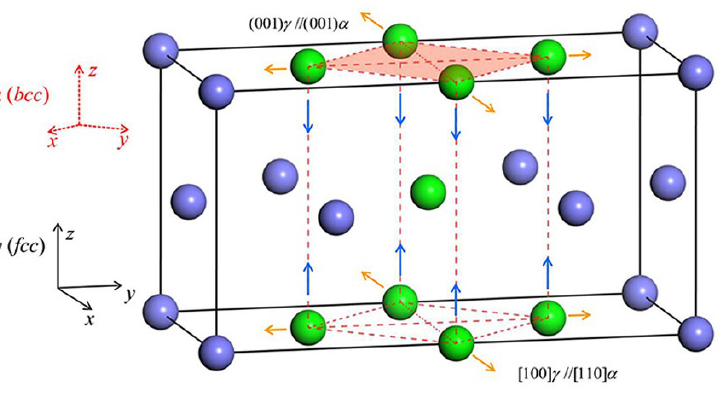
Figure 4. Illustration of martensitic transformation from FCC (blue atoms) to BCC lattice (green atoms). The transformation happens by compression in [001] (blue arrow direction and expansion in <110> (yellow arrow) direction [34]. Reproduced with permission from